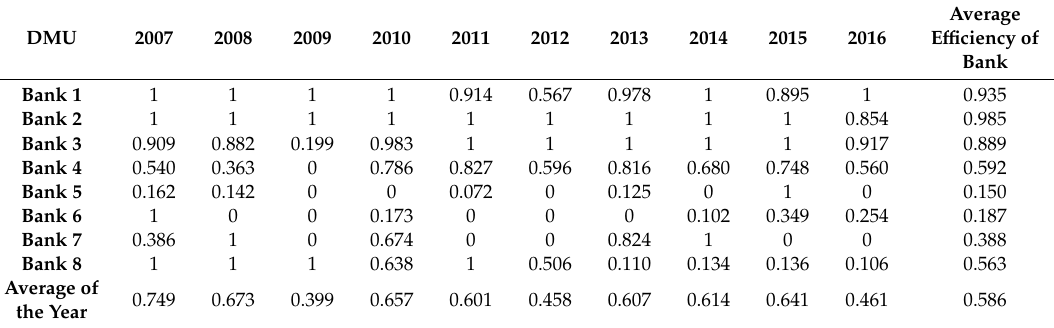
Table 10. Results of DEA model 2 (output oriented, VRS model, input Mortgage Credits, output Profit).